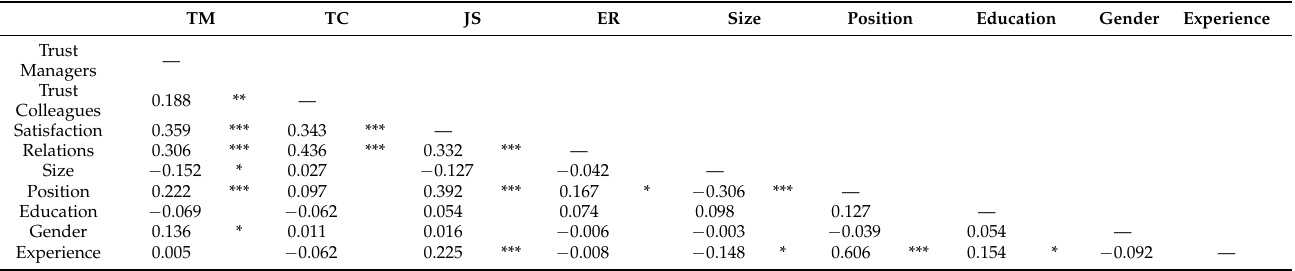
Table 6. Pearson correlation coefficients between study